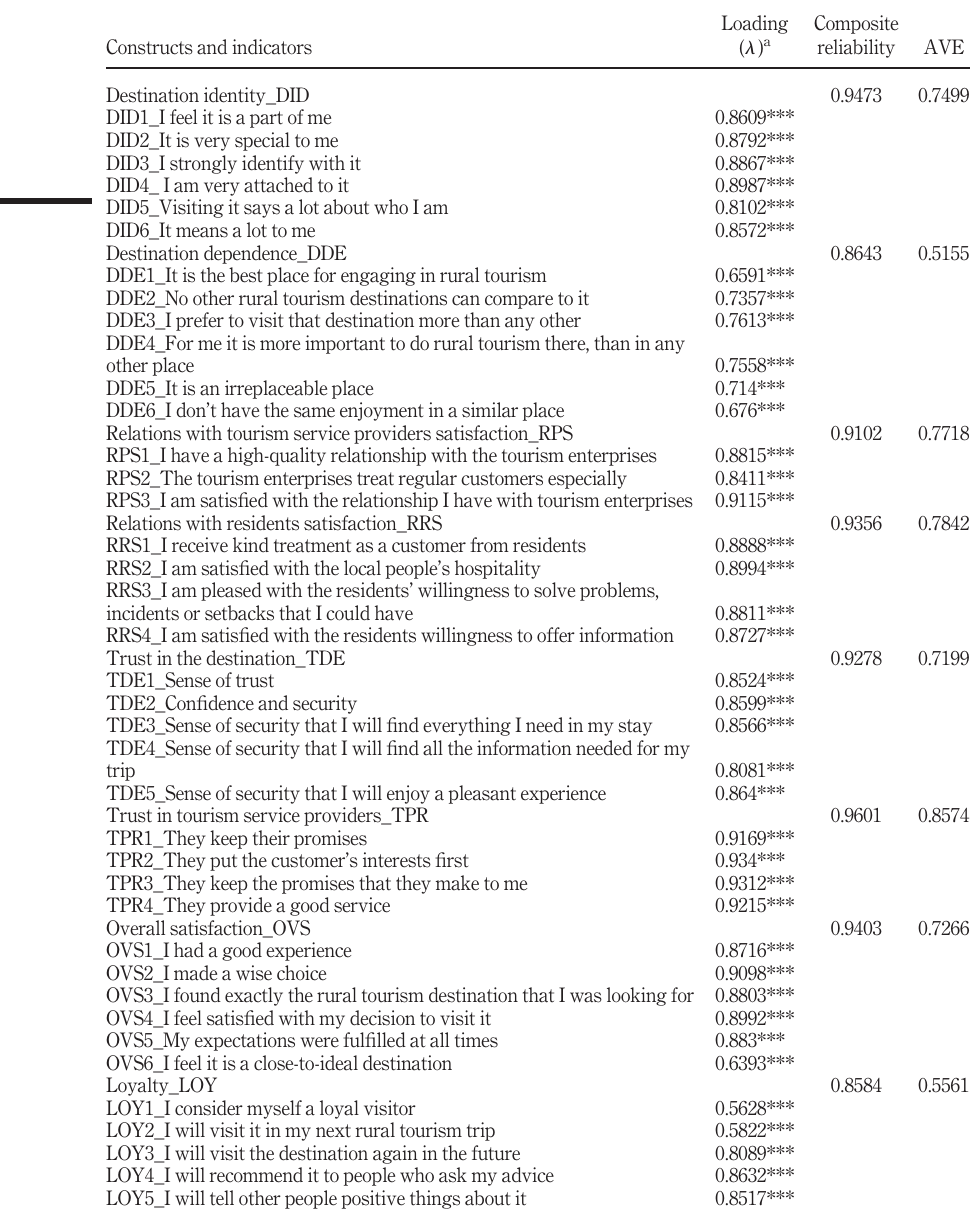
Table II. Measurement model